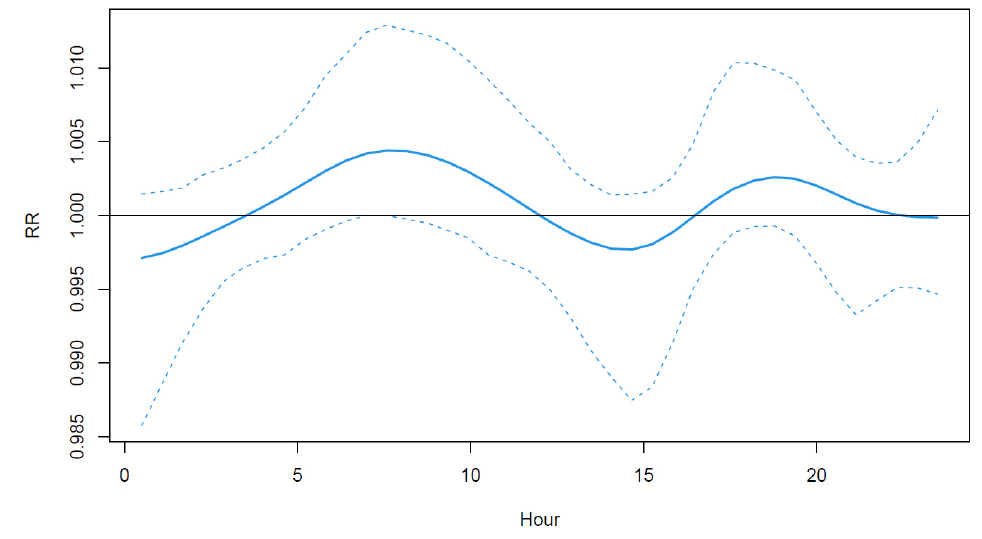
Figure 4. Estimated relationship between cardiovascular mortality count and the previous day temperature. From left to right, hours correspond to midnight of previous day to midnight of current day. Dashed lines indicate 95% confidence intervals. Seemingly low values of relative risk (RR) are due to the spreading of the risk along the whole day.